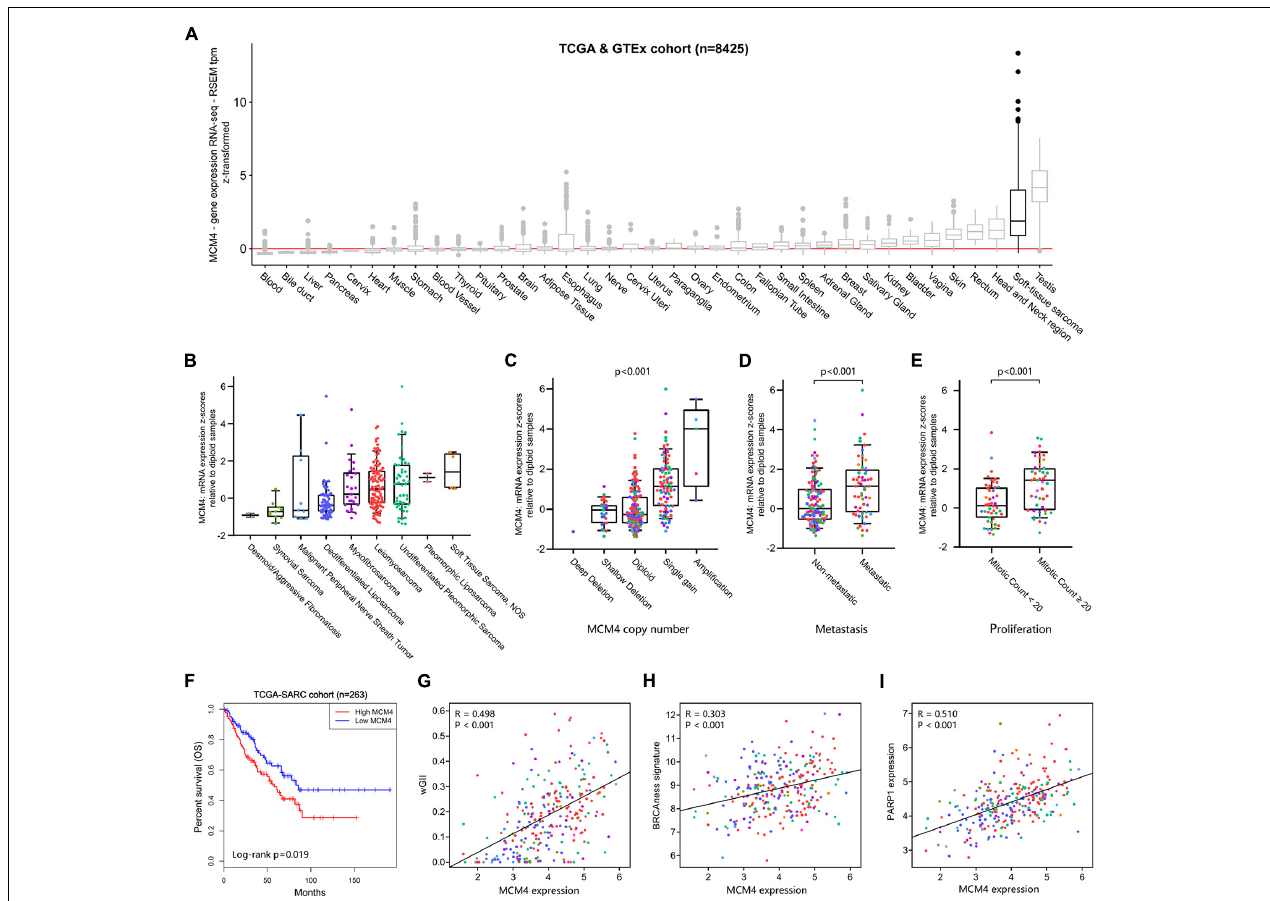
FIGURE 4 | Validation of MCM4 signature in pan-sarcoma cohorts. (A) MCM4 is highly expressed in soft-tissue sarcoma and testis, compared with the normal tissues. (B) The landscape of MCM4 expression in various soft-tissue sarcoma (STS) subtypes from TCGA database. (C–F) MCM4 expression was correlated with MCM4 copy-number (Kruskal-Wallis, p < < 0.001, n = 255), metastatic state (Wilcoxon test, p < 0.001, n = 179), proliferation index (Wilcoxon test, p < 0.001, n = 93), and patient overall survival (Log-rank test, p < 0.019, n = 263) across multiple histology subtypes in STS. (G–I) The tumoral expression of MCM4 was observed to be positively correlated with genome instability (weighted Genome Instability Index (wGII) score; p < 0.001, R = 0.498, n = 263), BRCAness signature ( p < 0.001, R = 0.303, n = 263), and PARP1 expression ( p < 0.001, R = 0.510, n = 263) in STS, via Spearman’s correlation analysis.